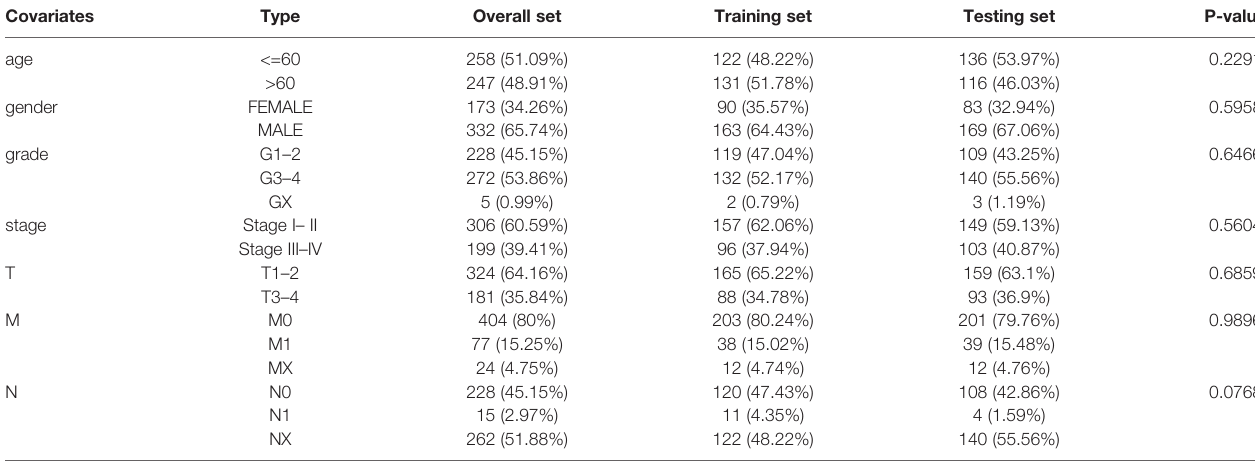
TABLE 1 | Comparison of clinical characteristics of KIRC* patients in training set and testing set.